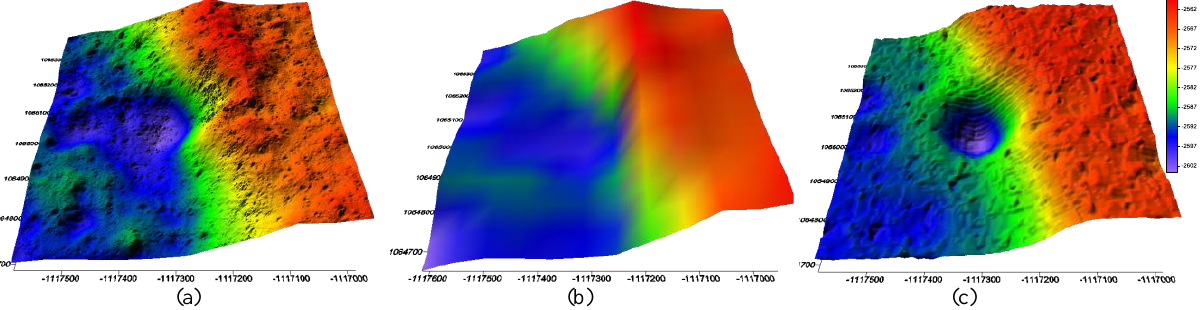
Figure 5. 3-D views of (a) the refined DEM (0.5 m/pixel) obtained with our SAfS algorithm, (b) the SLDEM2015 (60-m resolution) used as constraint, and (c) the NAC DEM (3-m resolution) used for